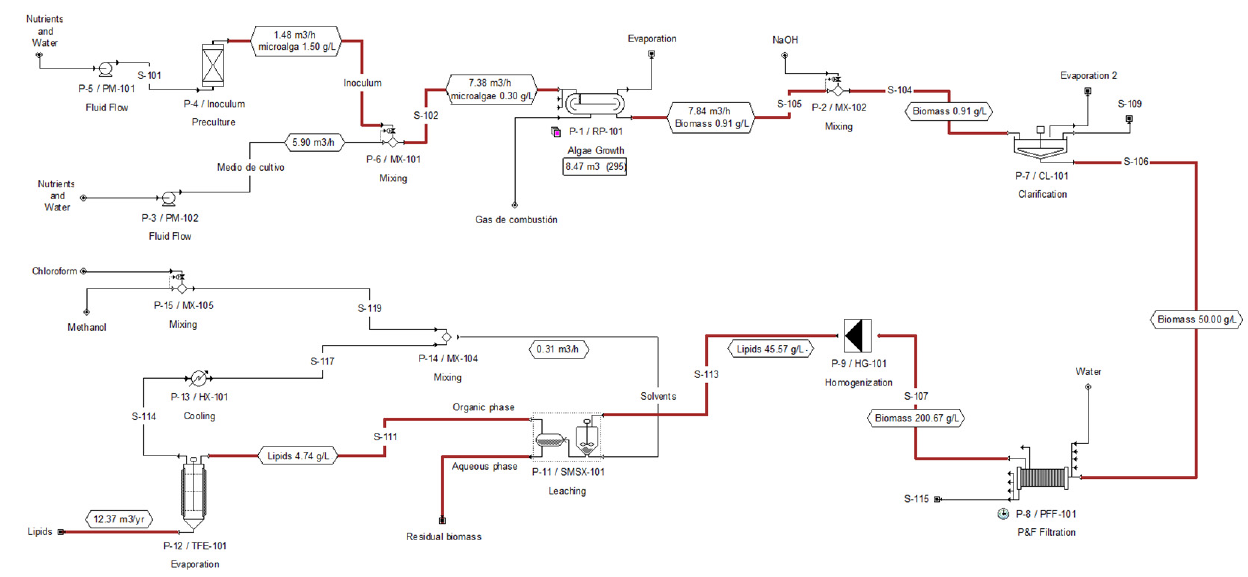
Figure 3. Flowsheet in SuperPro Designer for lipid production from wet biomass, scenario 2.